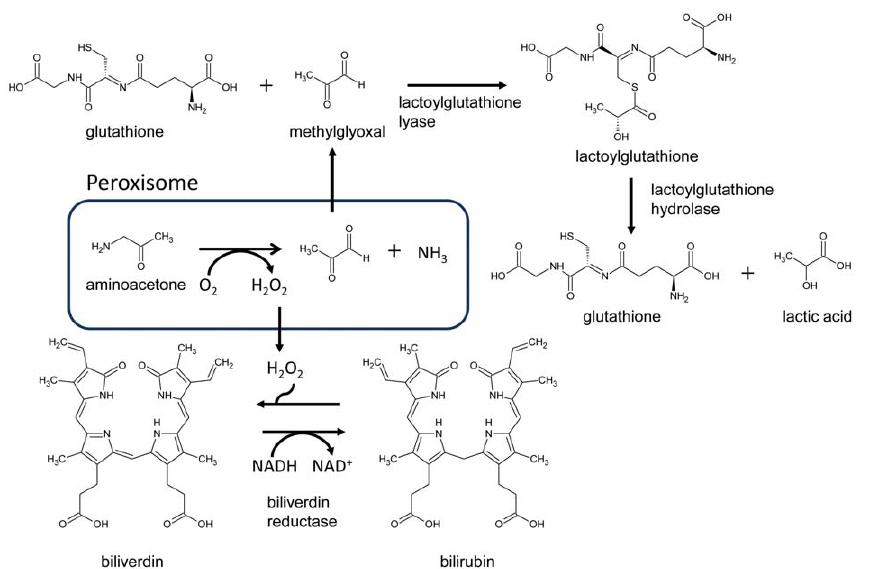
Figure 4. Example of a metabolic sub-network that was identified as being significantly more present in cancer tissues compared to their corresponding healthy tissues. Aminoacetone, which is a toxic by-product of amino acid catabolism, is converted to toxic methylglyoxal in a reaction that also result in hydrogen peroxide. The toxicity of methylglyoxal is relieved by two reaction steps involving ligation to glutathione and resulting in lactic acid. The generated hydrogen peroxide is taken care of by the enzyme biliverdin reductase. This is an example of how network- based analysis can lead to a more mechanistic interpretation of data.